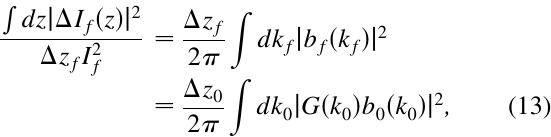
for a laser heater with a 0